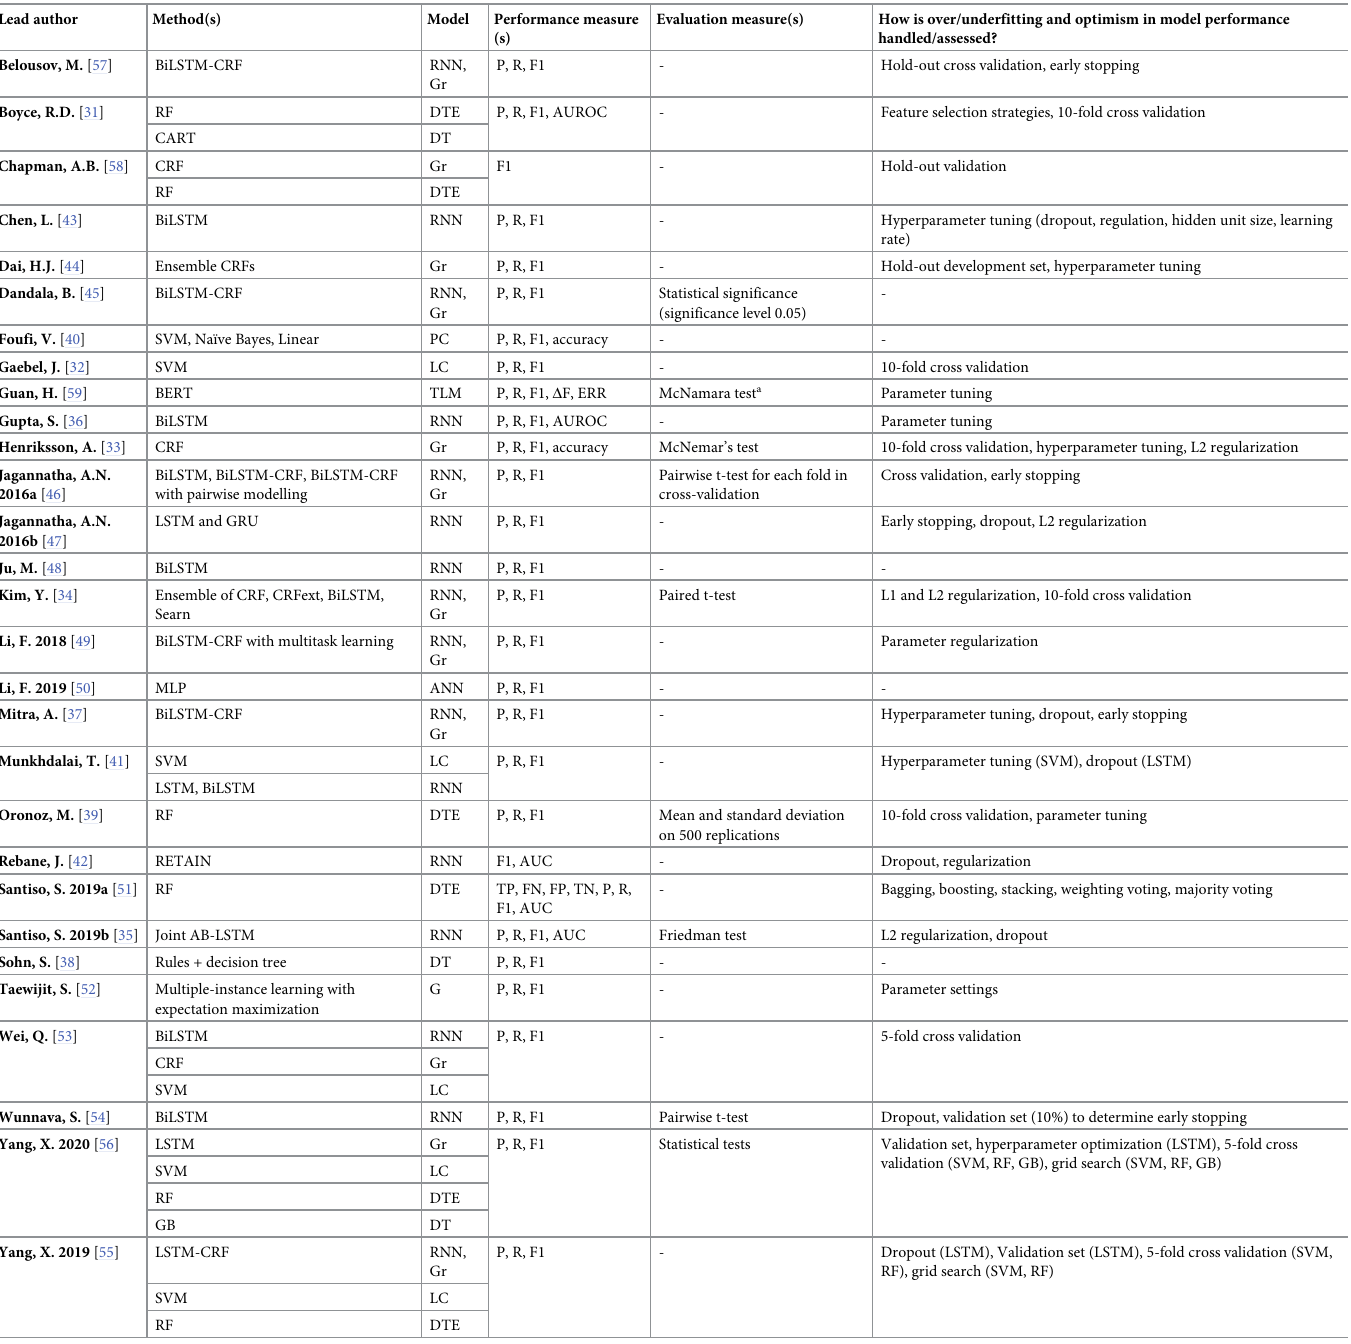
AB: attention-based bidirectional, BERT: Bidirectional Encoder Representations from Transformers, Bi: bidirectional, LSTM: long short term memory, CART: classification and regression tree, CRF: conditional random field, GB: gradient boosting, GRU: gated recurrent unit, MLP: multilayer perceptron, RETAIN: Reverse Time Attention, RF: random forest, SVM: support vector